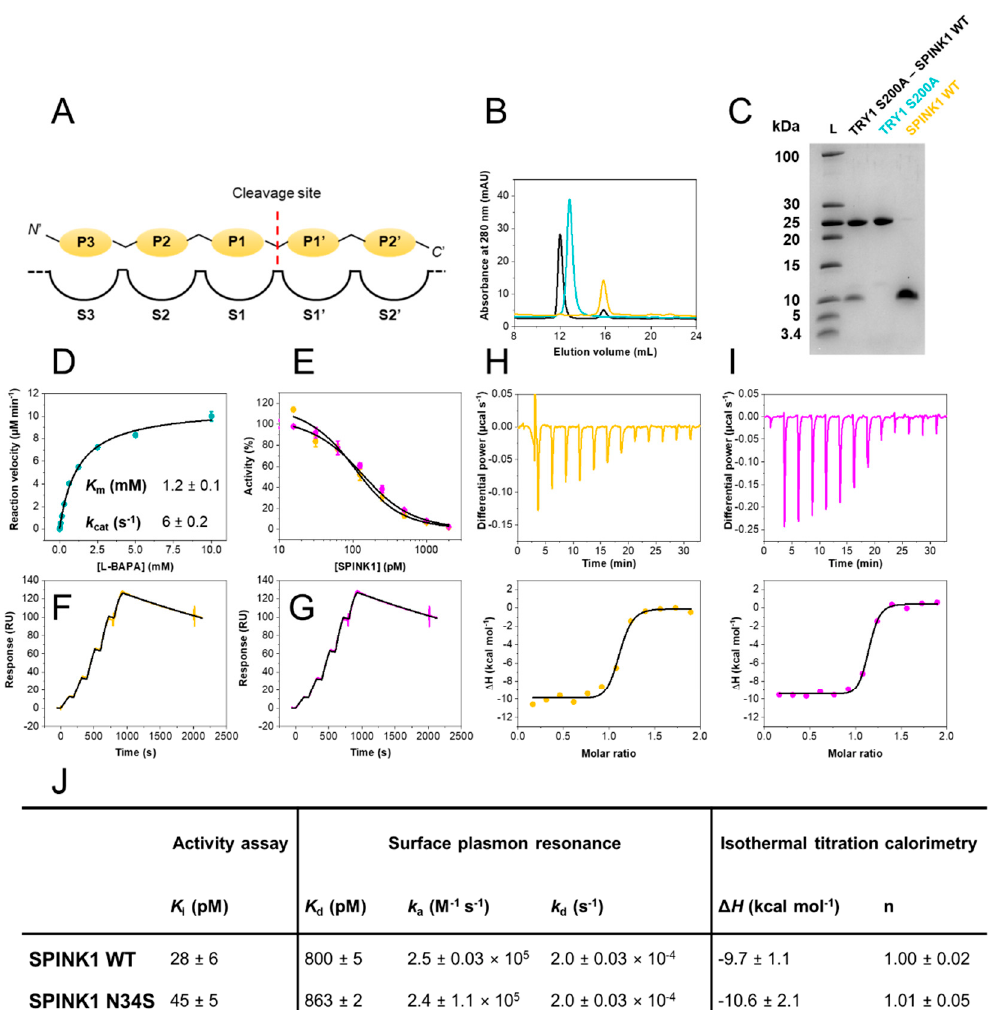
Figure 1. Biophysical characterization of the SPINK1–TRY1 interaction. ( A ) Schechter and Berger nomenclature. ( B ) Size-exclusion chromatograms of purified SPINK1 WT (yellow), TRY1 p.S200A (cyan) and complex (black). ( C ) 16% tricine SDS–PAGE of purified TRY1 p.S200A–SPINK1 WT com-